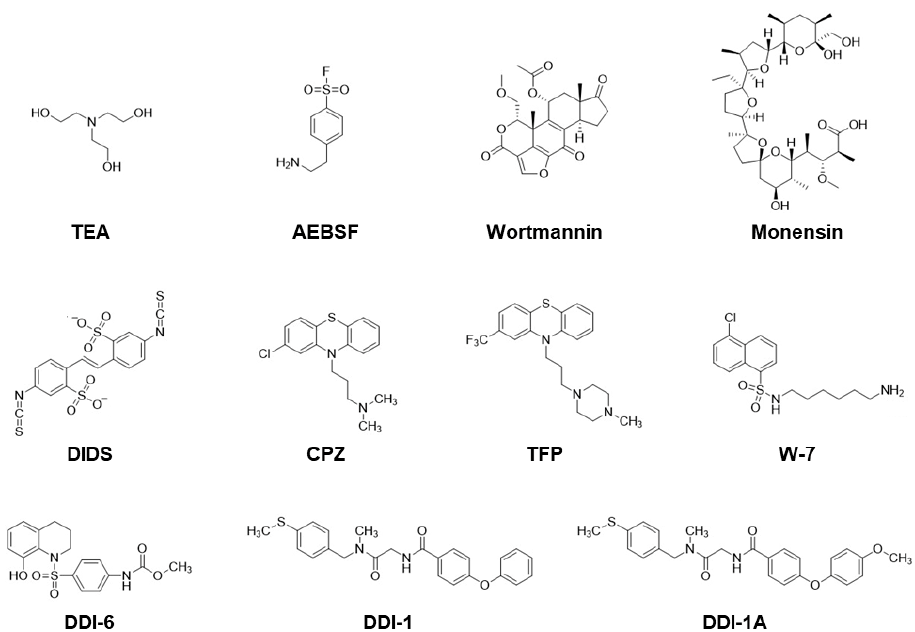
Figure 4. Chemical structures of the compounds that trigger or block spermiogenesis. For details, see Sections 3.1 and 3.2.